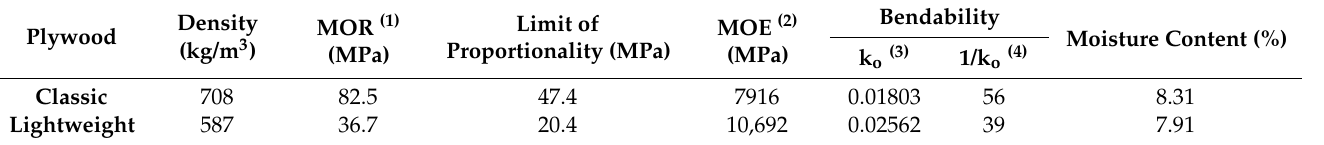
Table 1. Properties of tested plywood.